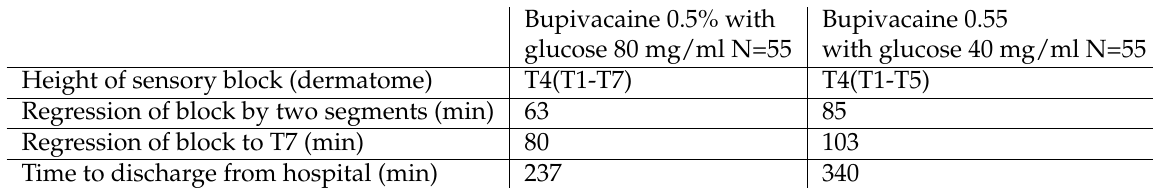
Table 2. Characteristics of sensory block in the two groups (median(10-90 th percentile)). Times are after spinal